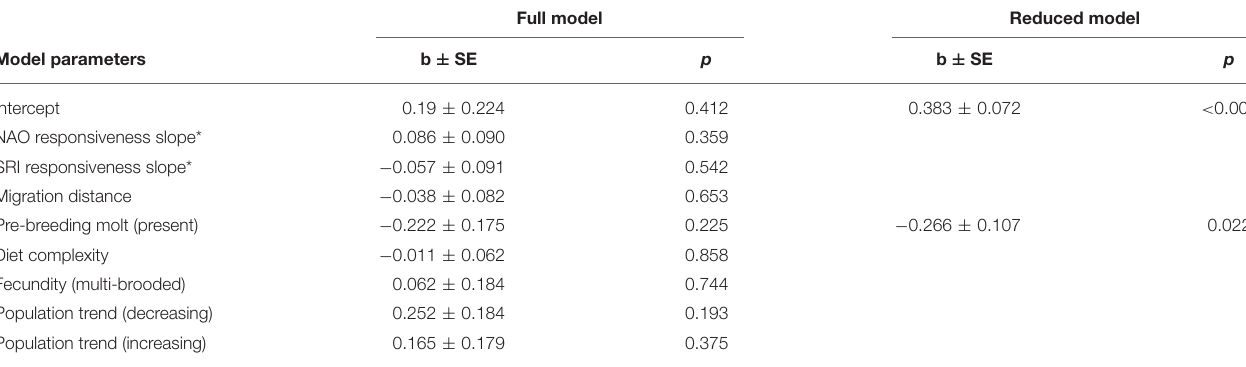
TABLE 2 | Phylogenetic generalized least squares models predicting the change in the frequency of overwintering at the study site ( N = 22